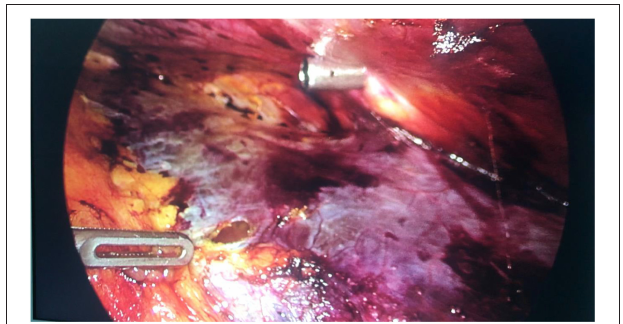
FIGURE 4 | Treatment of peritoneal damage.